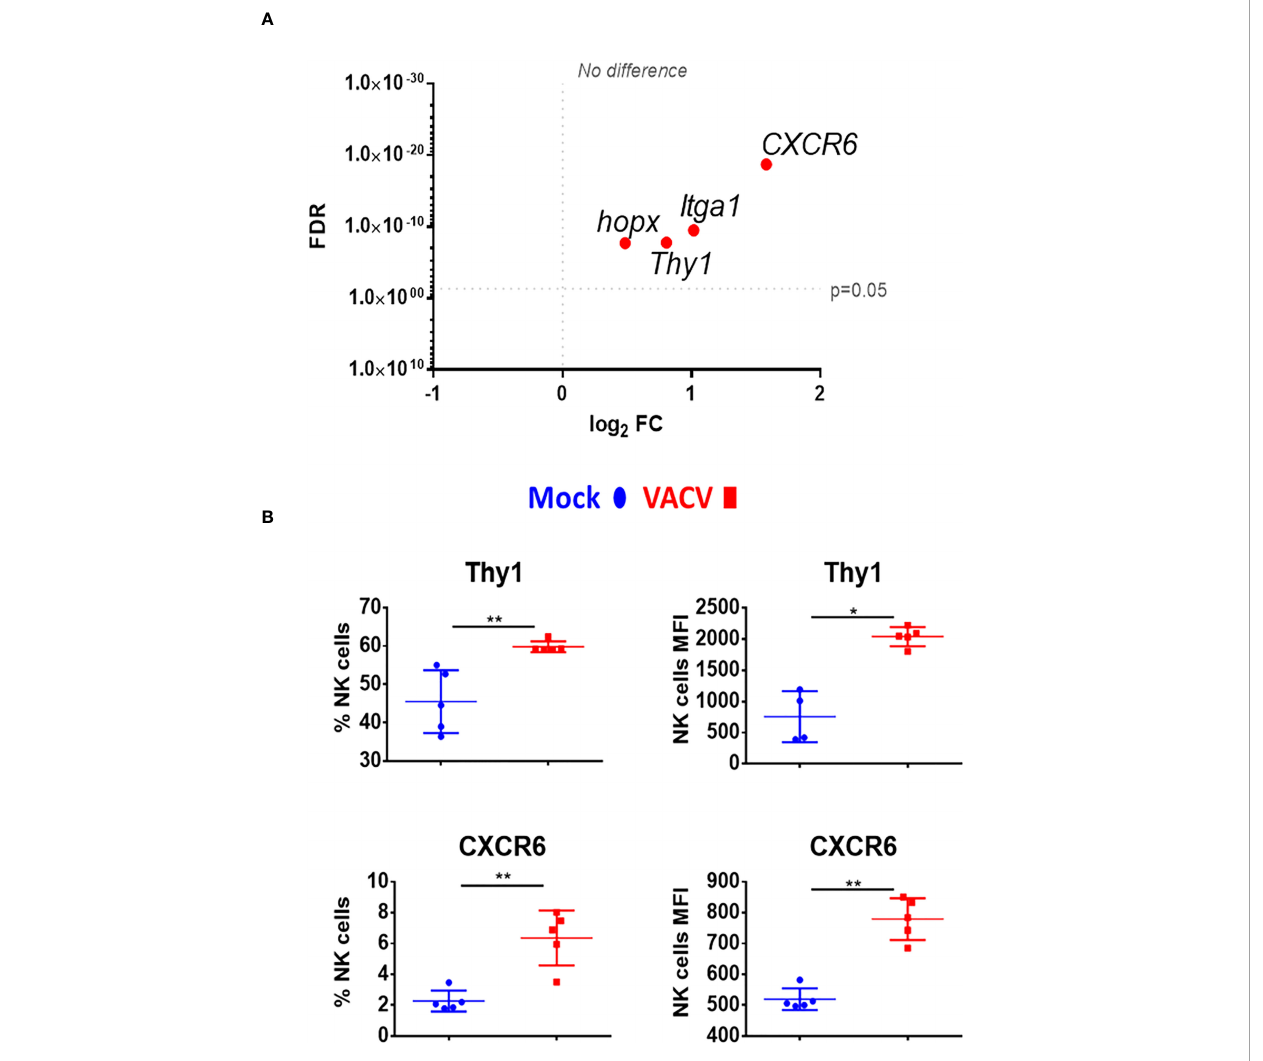
FIGURE 8 Upregulation of memory associated NK cell markers, at the transcriptional and protein level during VACV infection. (A) C57BL/6 mice (n=4) were infected with VACV WT or were mock-infected. At 6.5 d.p.i., NK cell transcriptional changes were studied by RNA-seq (n=4), and differential expression (VACV vs mock) was calculated. Each dot represents the differential expression pro fi les of the indicated gene (WT vs mock). Red indicates statistical signi fi cance (FDR<0.05). For clarity, the protein name is indicated rather than gene name. (B) Protein expression assessed by FACS for the indicated protein in splenic NK cells from mock (blue) and VACV-infected mice (red). The percentage of NK cells expressing the receptor and MFI for the indicated protein is shown. Error bars represent ± SD, statistical signi fi cance was assessed with a Mann-Whitney test (*p < 0.05, **p <